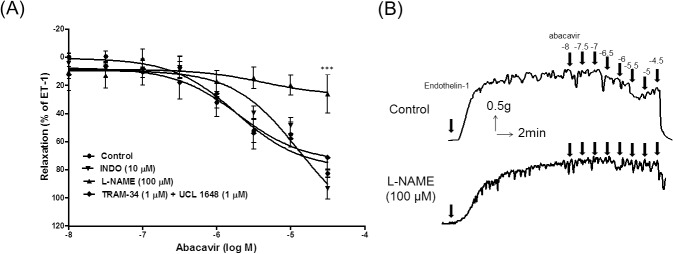
Involvement of NO, prostacyclin and EDHFs on abacavir-induced relaxation of rat basilar arteries.Rings of rat basilar arteries were treated with L-NAME (100 μM), indomethacin (INDO; 10 μM), or TRAM-34 (1 μM) plus UCL 1648 (1 μM) for 30 min. Rings without inhibitor treatment served as controls. Abacavir-induced relaxation of basilar arteries was then measured. (A) Changes in tension were expressed as the percentage decrease in response to contraction caused by endothelin-1 (ET-1; 1–10 nM). (B) Sample trace showing the effect of L-NAME on abacavir-induced relaxation. Values are means ± S.E.M of five sets of experiments and statistical comparisons were made using ANOVA. *** P<0.005 compared with control.